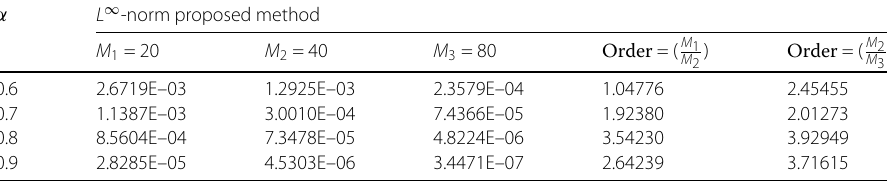
at T = 1 for Problem 1 M